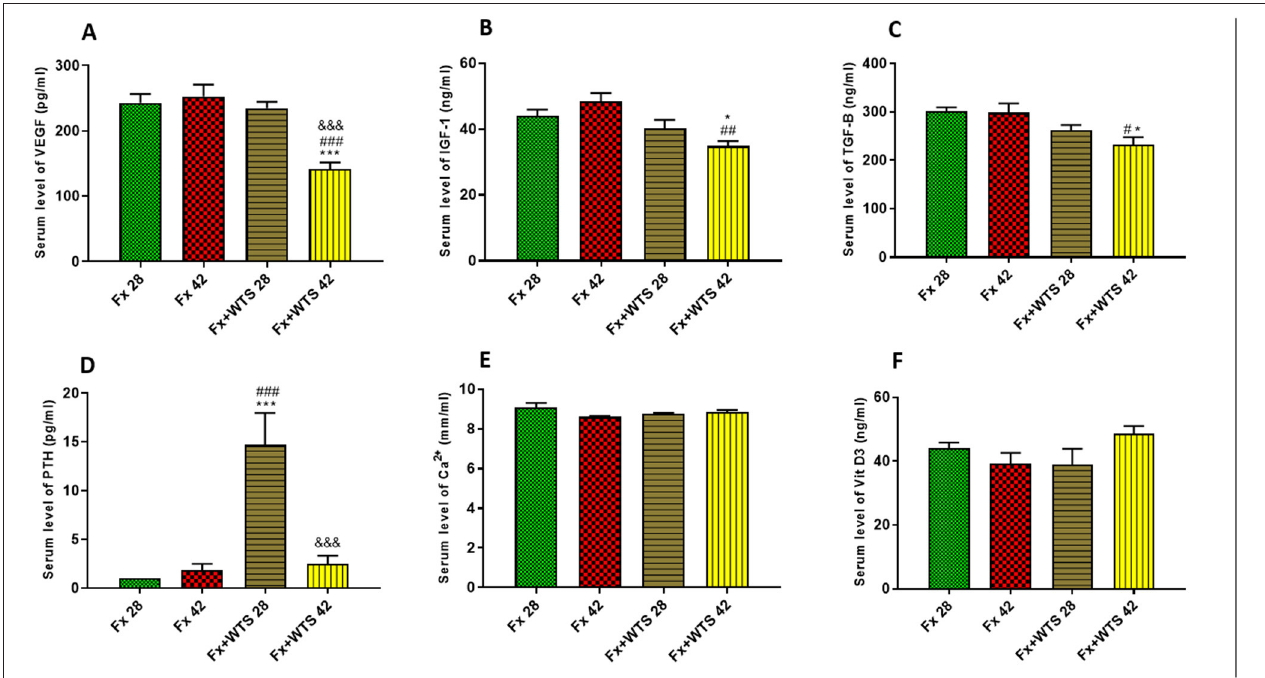
FIGURE 12 | Effects of WTS on the serum levels of (A) VEGF, (B) insulin-like growth factor 1 (IGF-1), (C) transforming growth factor-beta (TGF- β ), (D) parathyroid hormone (PTH), (E) Ca 2 + , and (F) vitamin D3 (Vit D3) in experimental groups. Fx 28: group subjected to room air for 28 days after surgery and a femoral bone fracture, Fx 42: group subjected to room air for 42 days after surgery and a femoral bone fracture, Fx + WTS 28: group subjected to WTS for 28 days after surgery and a femoral bone fracture, Fx + WTS 42: group subjected to WTS for 42 days after surgery and a femoral bone fracture. The results are presented as mean ± SEM, n = 7. * P < 0.05, *** P < 0.001 vs. Fx 28; # P < 0.05, ## P < 0.01, ### P < 0.001 vs. Fx 42; &&& P < 0.001 vs. Fx + WTS